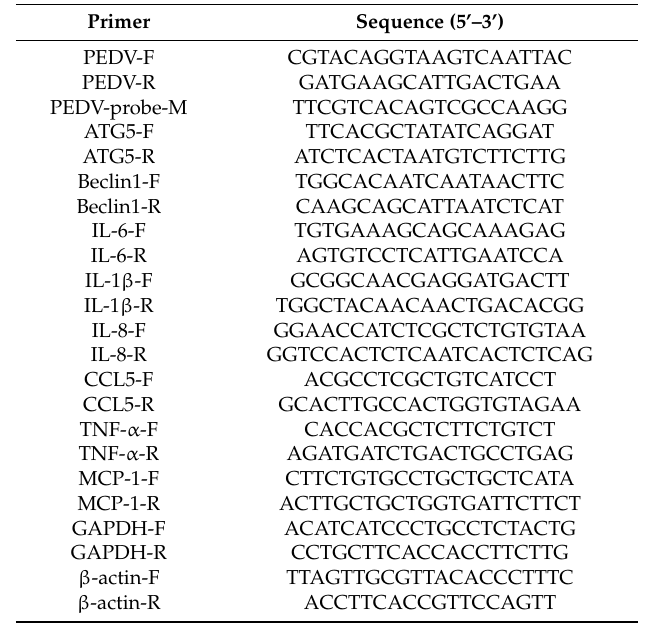
Table 1. Primers used for real-time real time